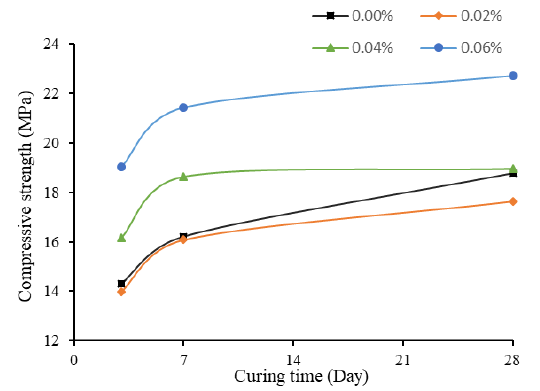
Figure 5. Compressive Strength of TX10 added mortar cubes.